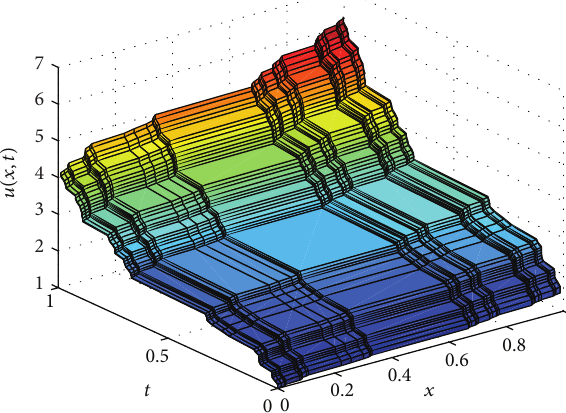
Figure 2: The plot of solution of (28) when 𝛼 = ln 2/ ln 3